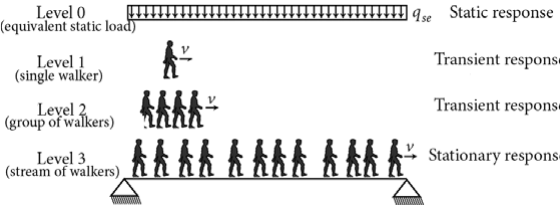
Fig. 1. Approaches for the evaluation of walking-induced response of